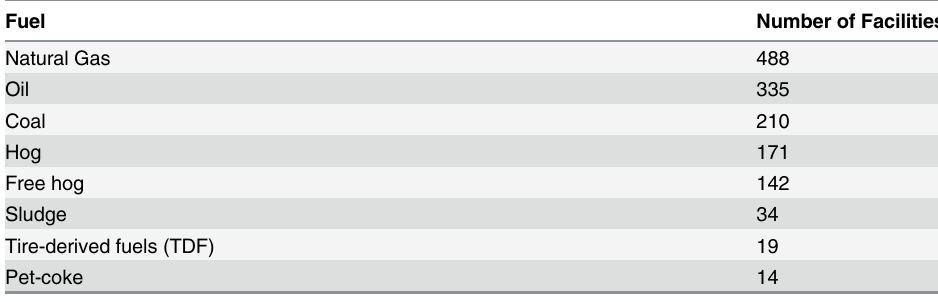
Table 6. Fuel availability